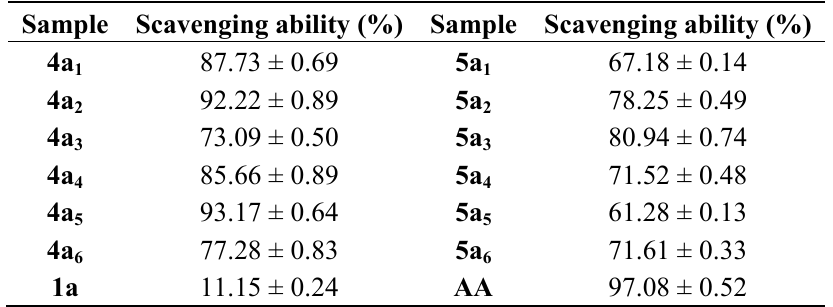
Table 8. DPPH radical scavenging ability of sulfisoxazole derivatives 4b